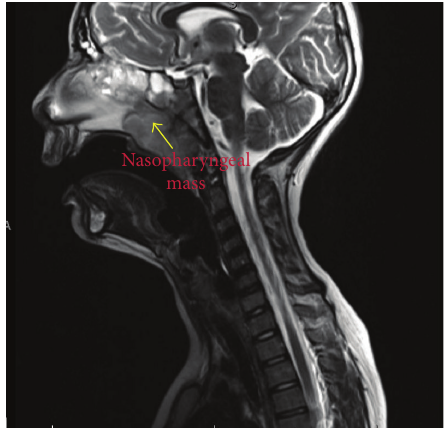
Figure 2: Nasopharyngeal mass causing airway obstruction.